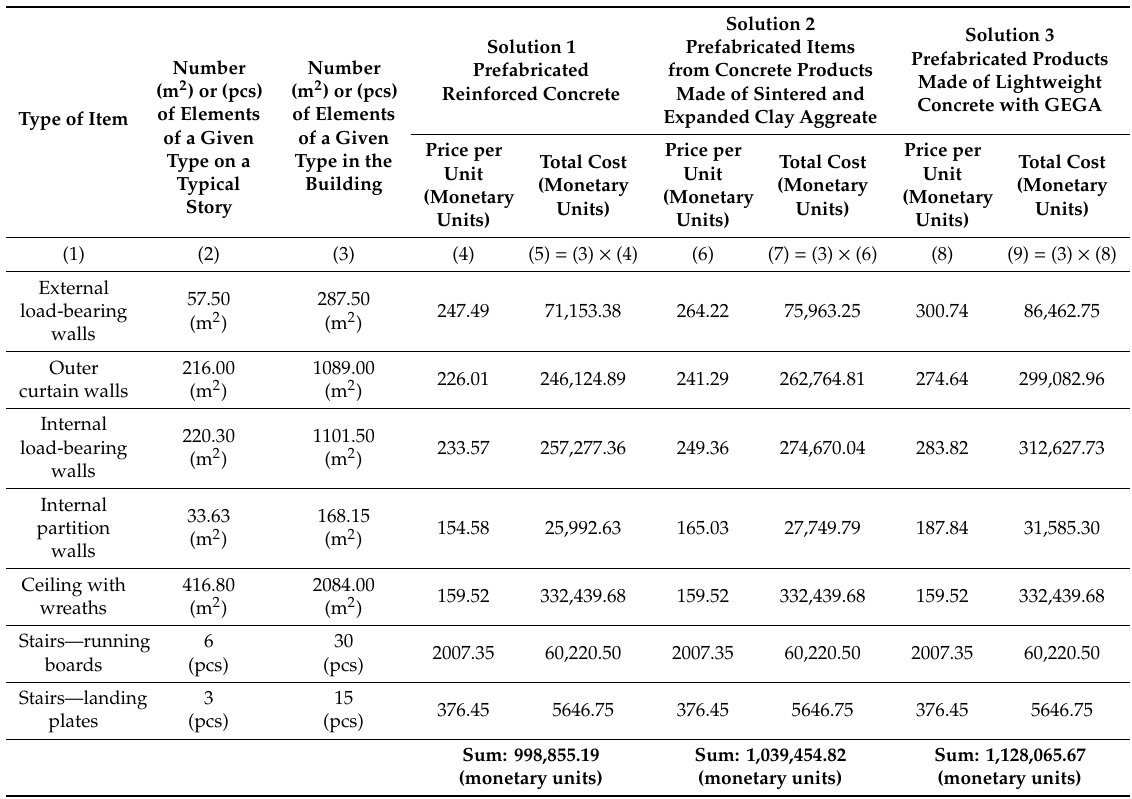
Figure 3. A multi-family, five-story, three-frame residential building. Source: own photo of the authors. Table 6. List of structural elements for five storeys of the building, unit prices and total cost of walls, ceilings and stairs according to solutions 1, 2,